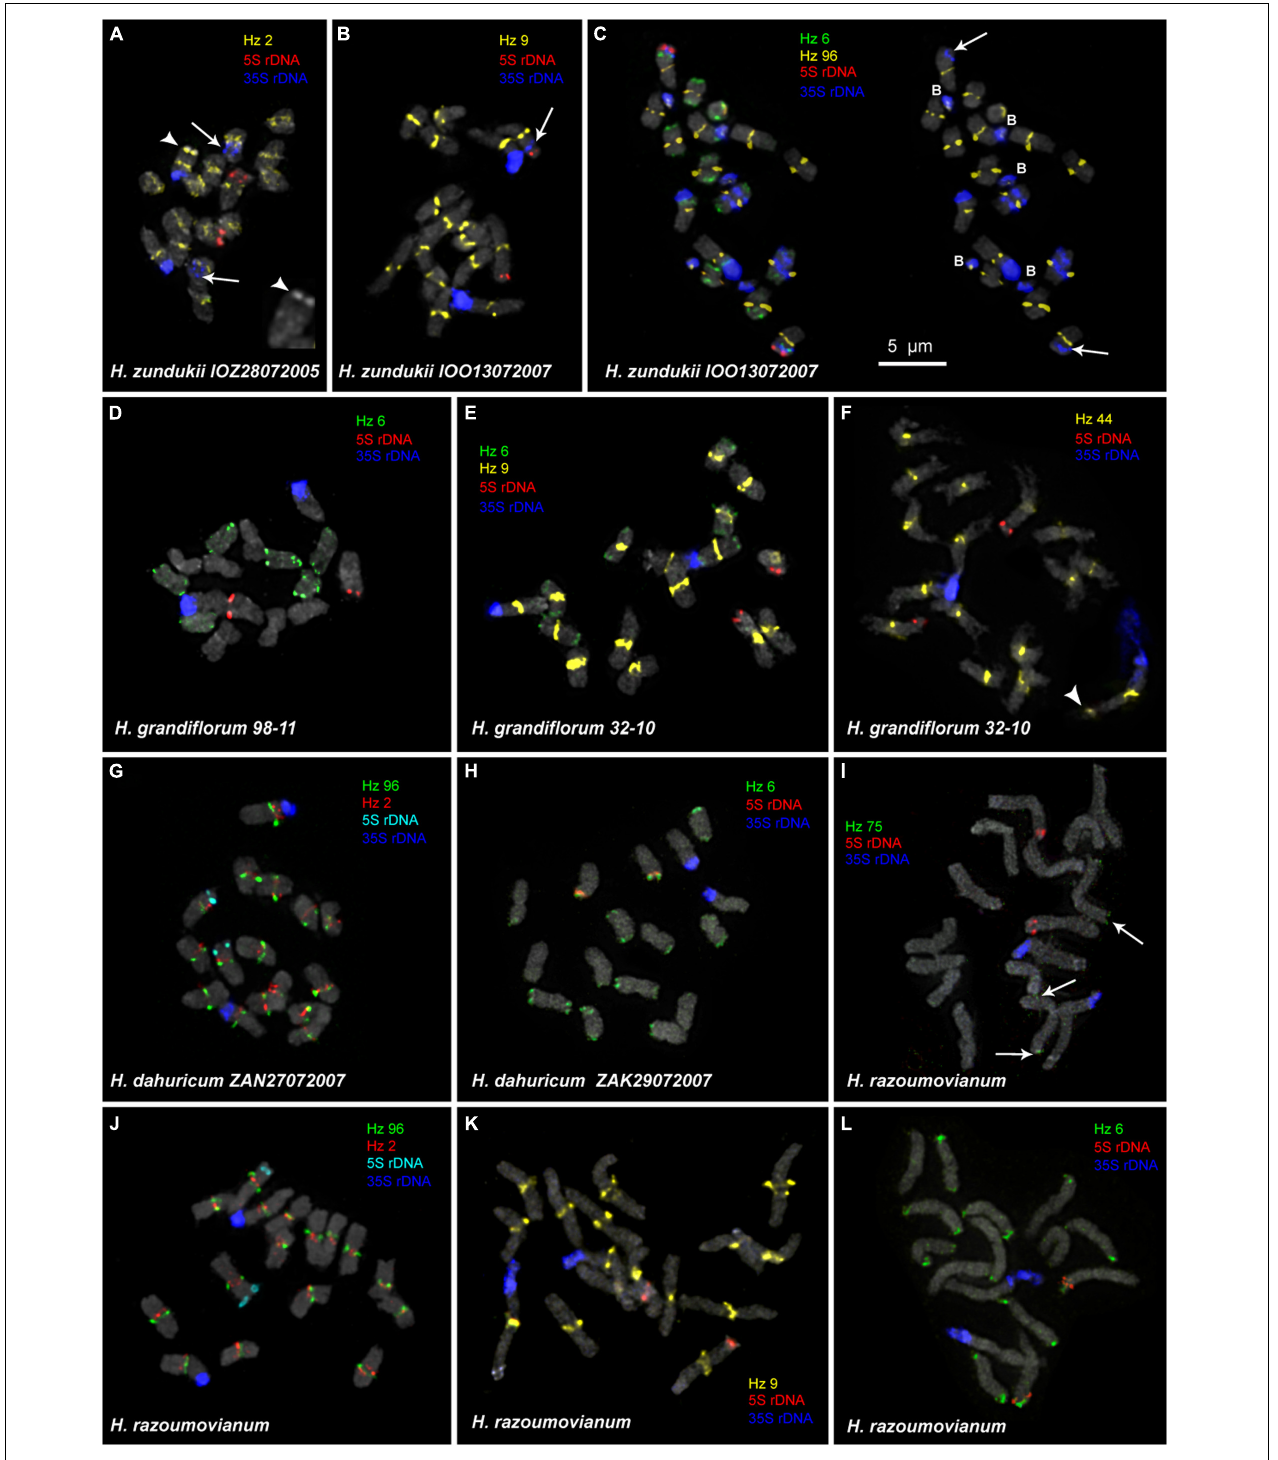
FIGURE 4 | FISH-based localization of 5S rDNA, 35S rDNA, and satellite repeats on the metaphase spreads of the studied accessions of H. zundukii (A–C) , H. grandiflorum (D–F) , H. dahuricum (G–H) , and H. razoumovianum (I–L) . The correspondent probes and their pseudocolors are specified next to the metaphase spreads. Arrows point to polymorphic sites of 35S rDNA of H. zundukii (A–C) . Heads of arrows point to the Hz 2 site on the satellite chromosome of H. zundukii (A) and the Hz 44 site on the satellite chromosome of H. grandiflorum (F) . The increased fragment of one homolog of SAT chromosome of H. zundukii (A) with a large terminal DAPI-band is presented right below (head of arrow). Arrows point to the Hz 75 sites on chromosomes of H. razoumovianum . B, B chromosomes. Bar—5 µ m.